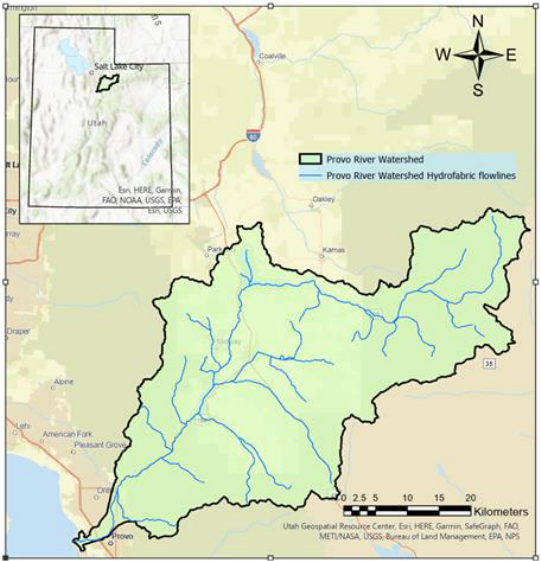
Figure 10. Utah County Hydrofabric flowlines.